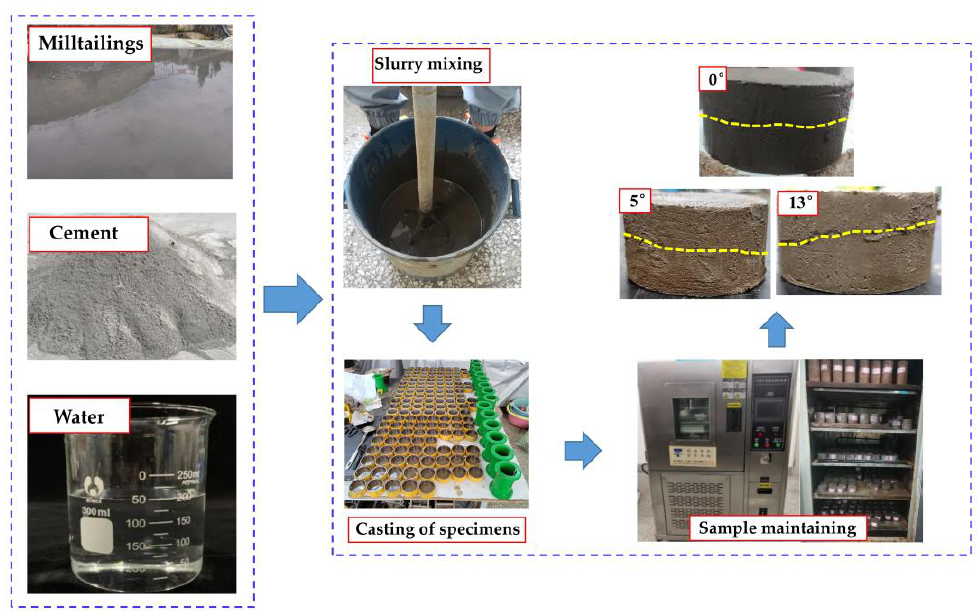
Figure 4. Preparation of stratified backfill specimen.